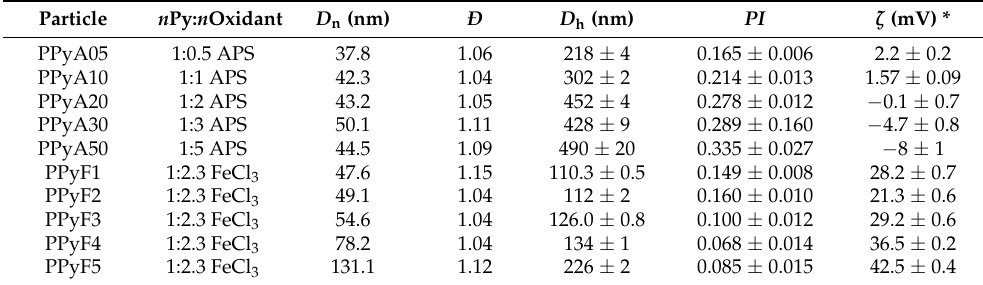
Figure 2. UV ‐ Vis spectra of the polypyrrole nanoparticles prepared by oxidation of Py monomer with different molar ratios of APS (samples PPyA05, PPyA10, PPyA20, PPyA30 and PPyA50) dispersed in physiological PBS (c = 55 μ g/mL). Table 1. Properties of the prepared particles: oxidant used for preparation and its ratio, particle diameter ( D n ) and dispersity ( Ð ), hydrodynamic diameter ( D h ), polydispersity index ( PI ), ζ -potential. Particle n Py: n Oxidant D n (nm) Ð D h